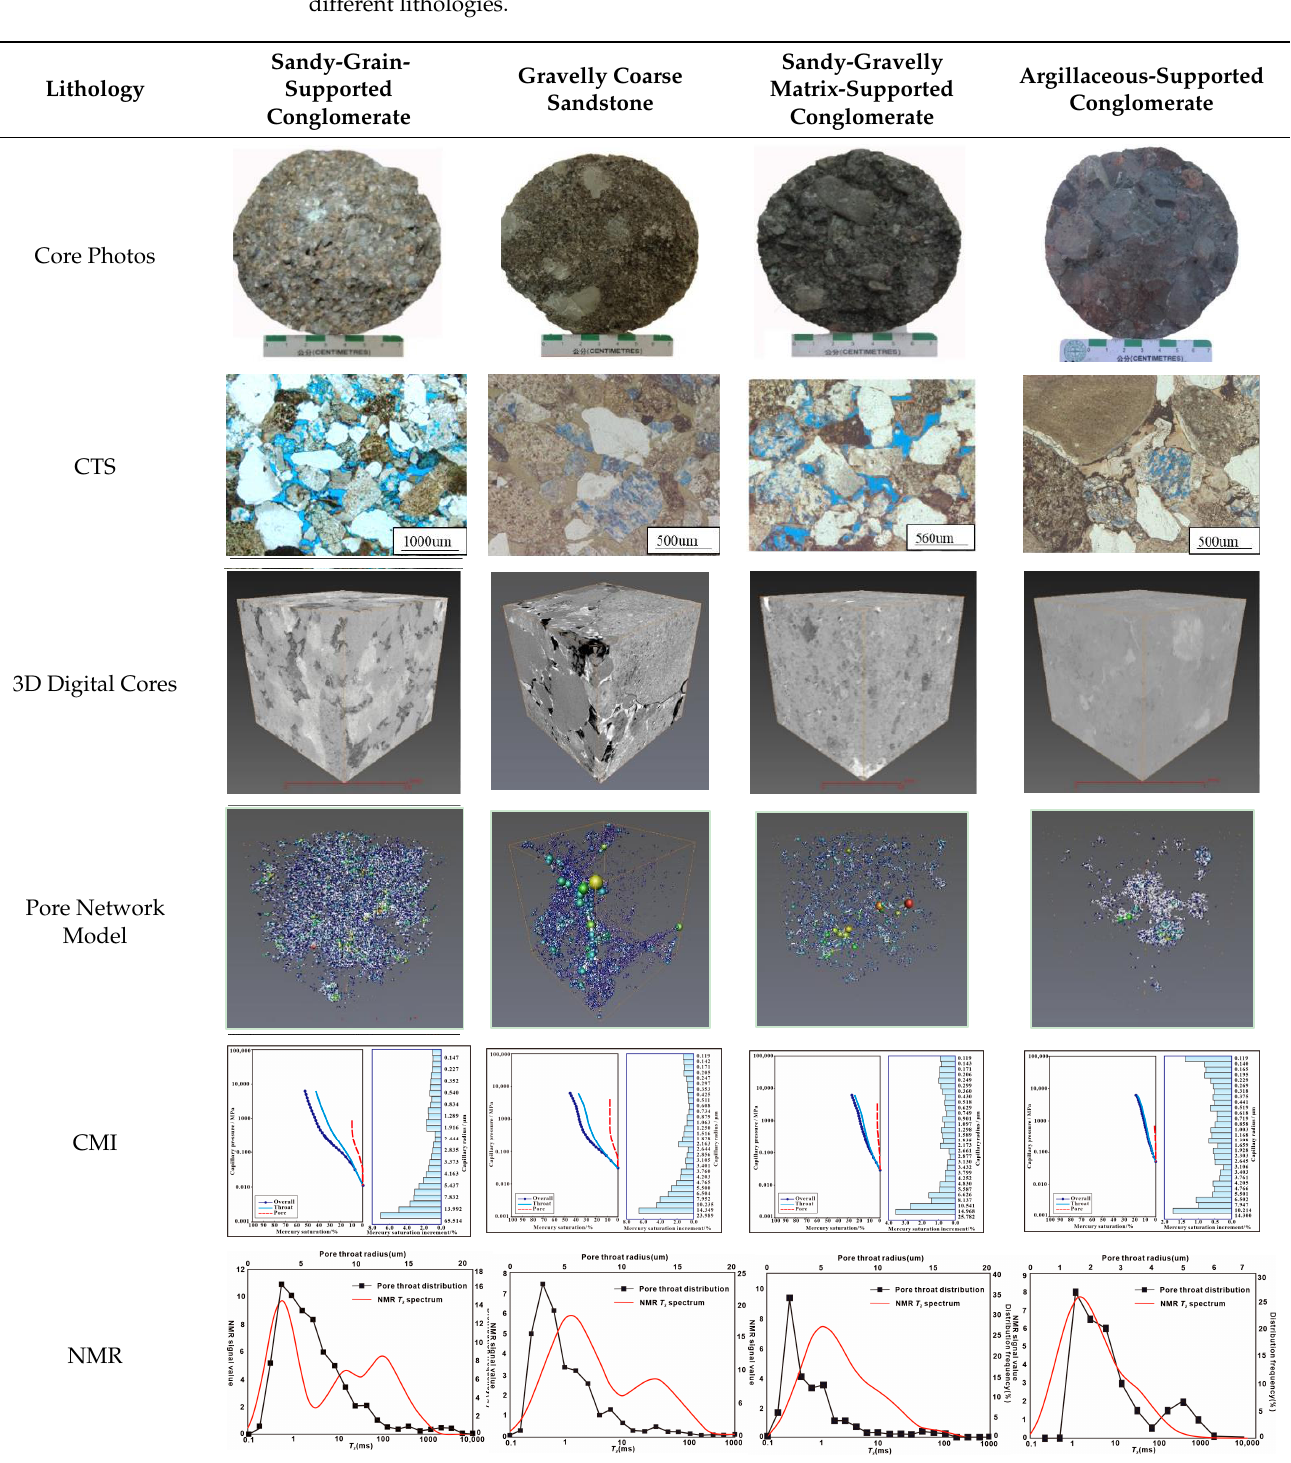
Table 3. Microscopic pore structure parameters of core samples with different lithologies.